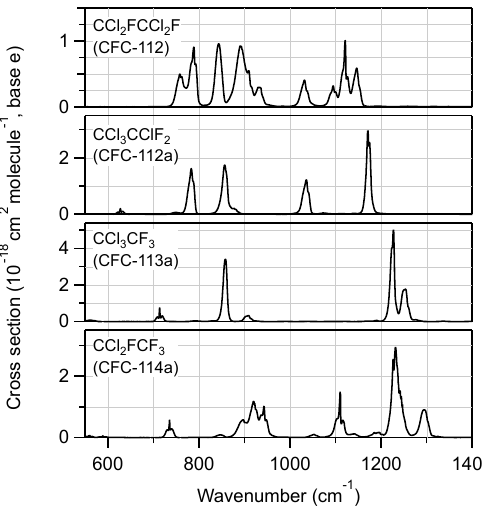
Figure 4. Infrared absorption spectra of CCl 2 FCCl 2 F (CFC-112), CCl 3 CClF 2 (CFC-112a), CCl 3 CF 3 (CFC-113a), and CCl 2 FCF 3 (CFC-114a) at 296K obtained in this